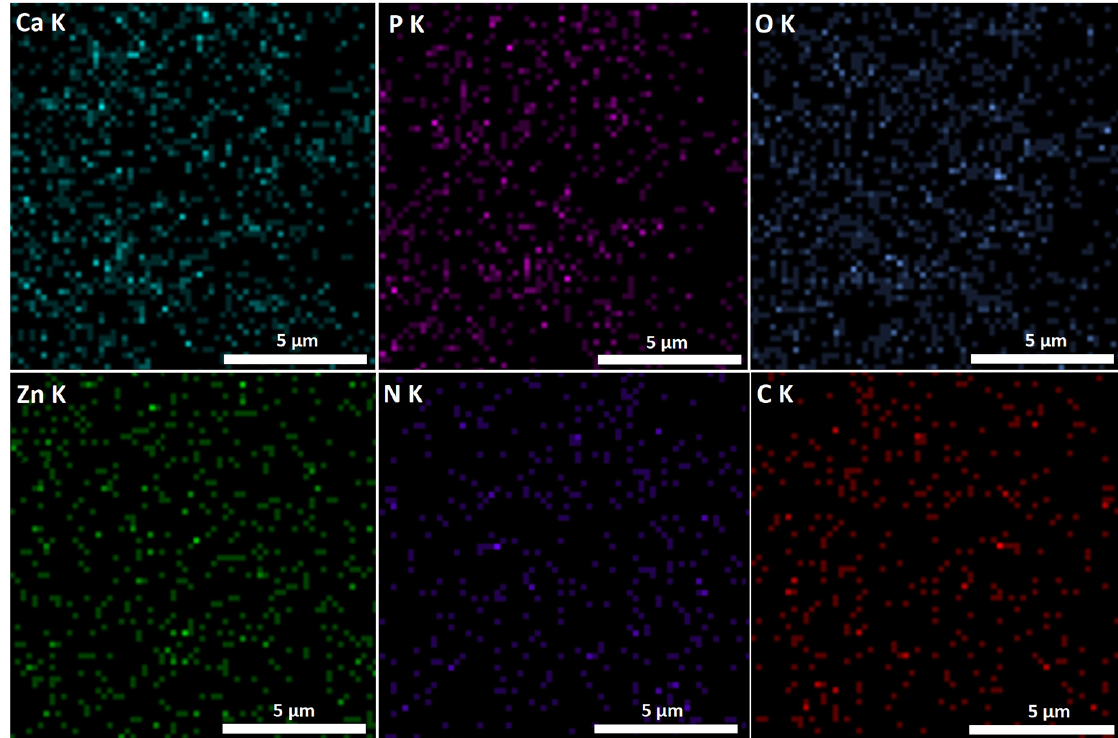
Figure 4. The EDX elemental distributions obtained for ZnHApC-14D coating.